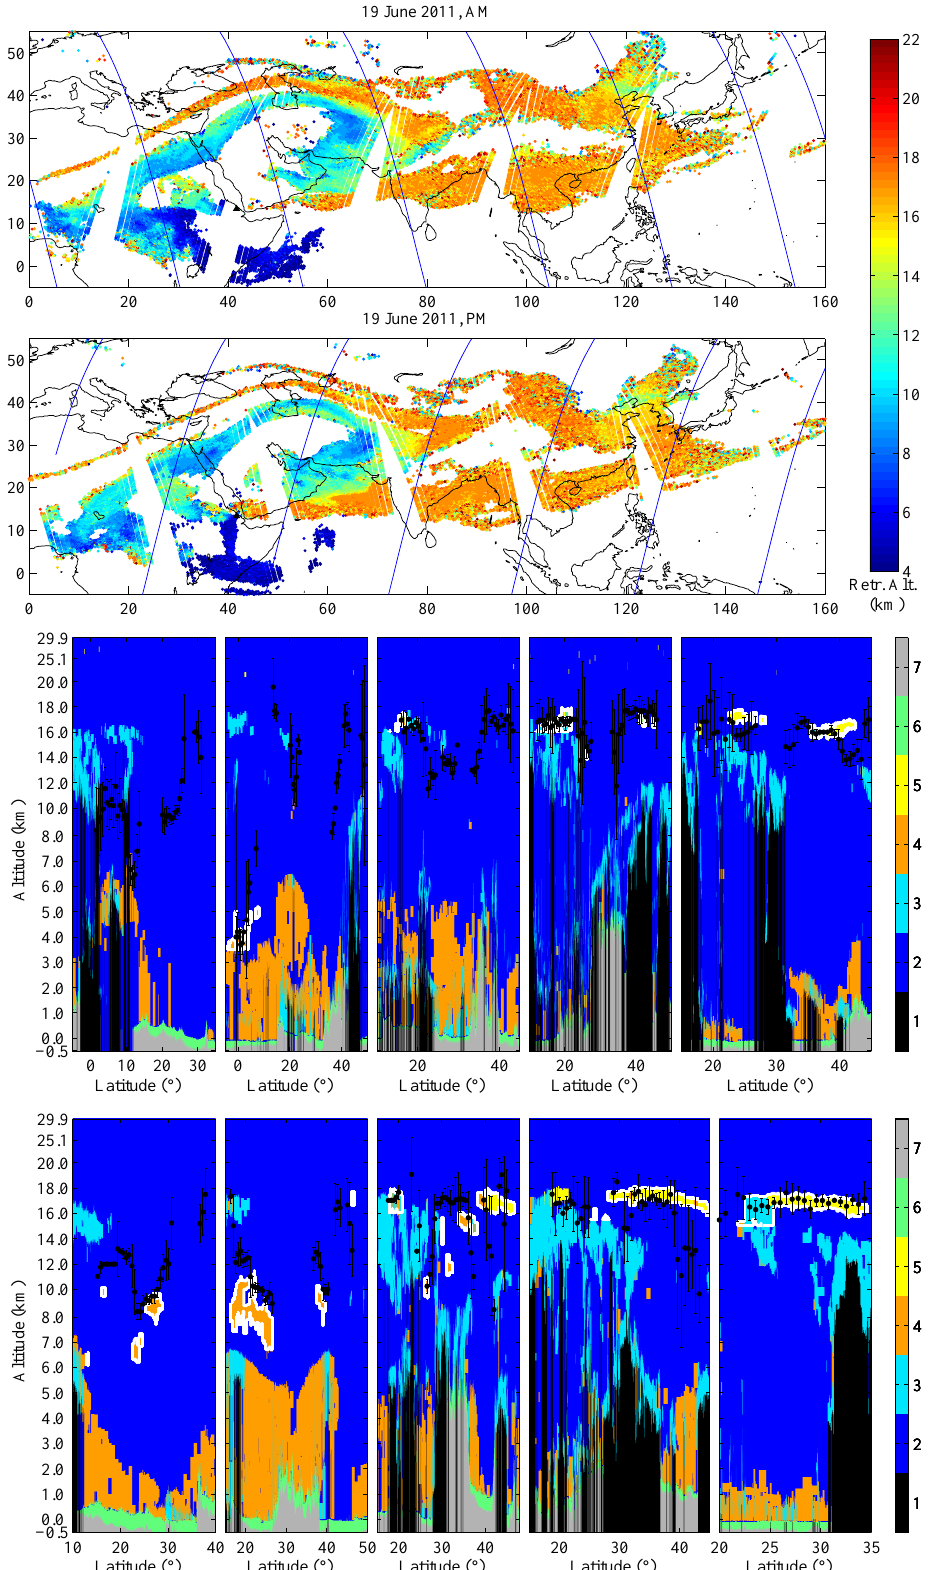
Fig. 10. Same as Fig. 6 for 19 June